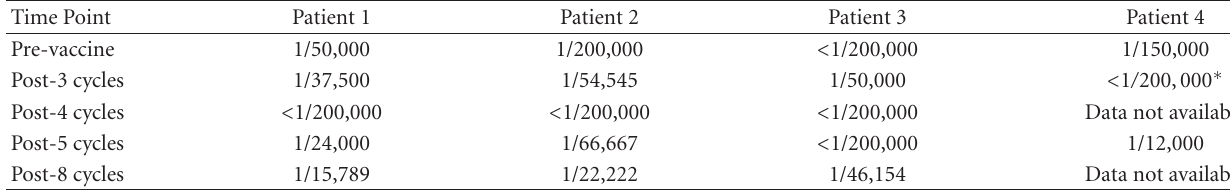
Table 1: ELISPOT PSA-specific T cells for patients with node positive disease at various time points during vaccination. Patient 1 is the only patient with detectable PSA-specific T cells prior to starting vaccination. It should be noted that the post-4 immune responses were obtained mid-radiation, and unlike the other time points, this blood was prepared from a peripheral blood draw rather than an apheresis sample. Interestingly, radiation has been shown to upregulate markers on the tumor facilitating tumor specific T-cell tra ffi cking which may impact peripheral circulation of antigen specific T-cells (reviewed in [4]). It is possible that either of these variables could have impacted the measured immune response. ∗ Post-2 cycles.